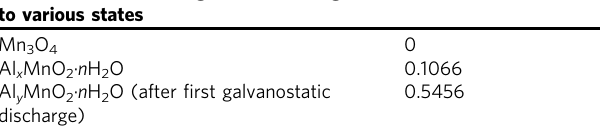
Table 2 The Al/Mn atomic ratios of the nanoparticles obtained from the cathode charged and discharged to various states Cathode materials charged and discharged to various